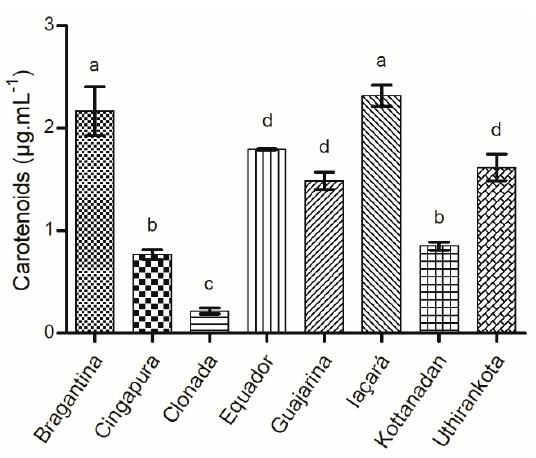
Figure 5. Total carotenoids produced in the leaves of black pepper cultivars. a–d Different letters represent a statistically significant difference by Tukey’s test ( p < 0.05).